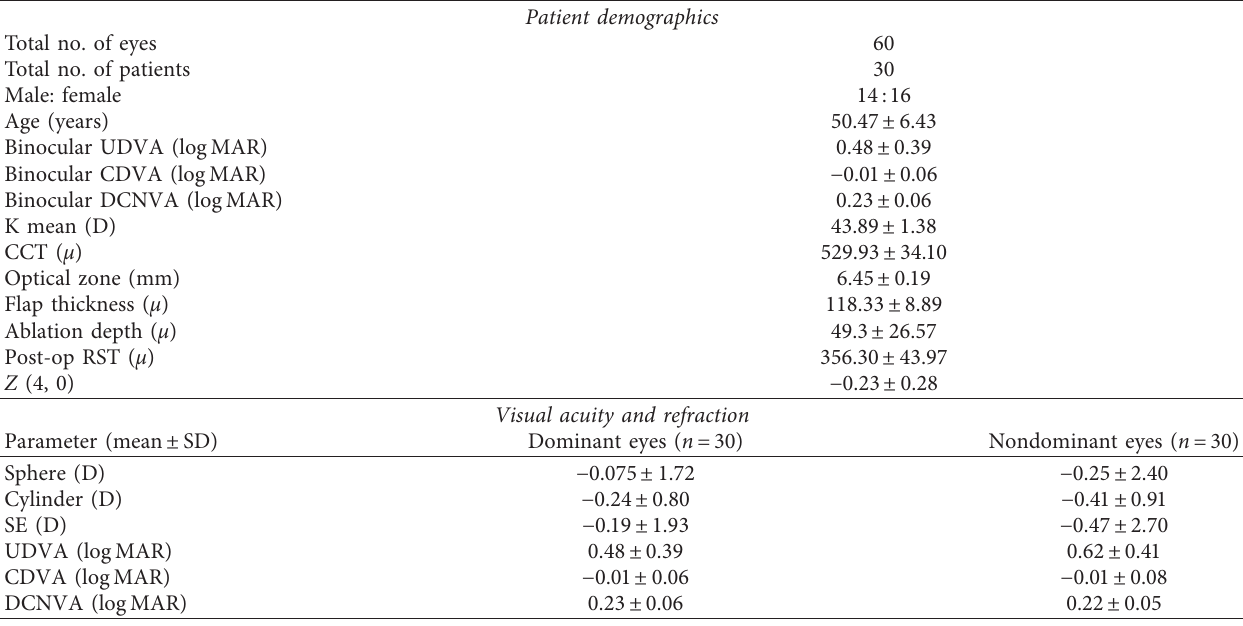
Table 1: Patient demographics and preoperative data.